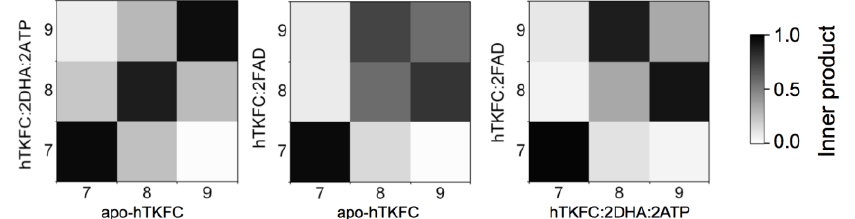
Figure 4. Comparison of normal modes NM7 – NM9 for the three systems studied. A set of conformations was generated for each system and mode, and the information about their C α atoms was extracted such that the same number of atoms was considered in each case. The resulting trajectories were submitted to principal component analysis from where eigenvectors and eigenvalues were derived. Inner products were calculated for each comparison and are displayed in a grey scale: from 1.0, identity, to 0.0, orthogonality.